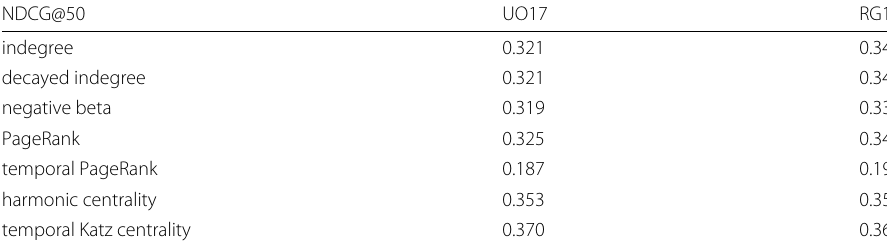
Table 3 Best average NDCG@50 performance of each centrality